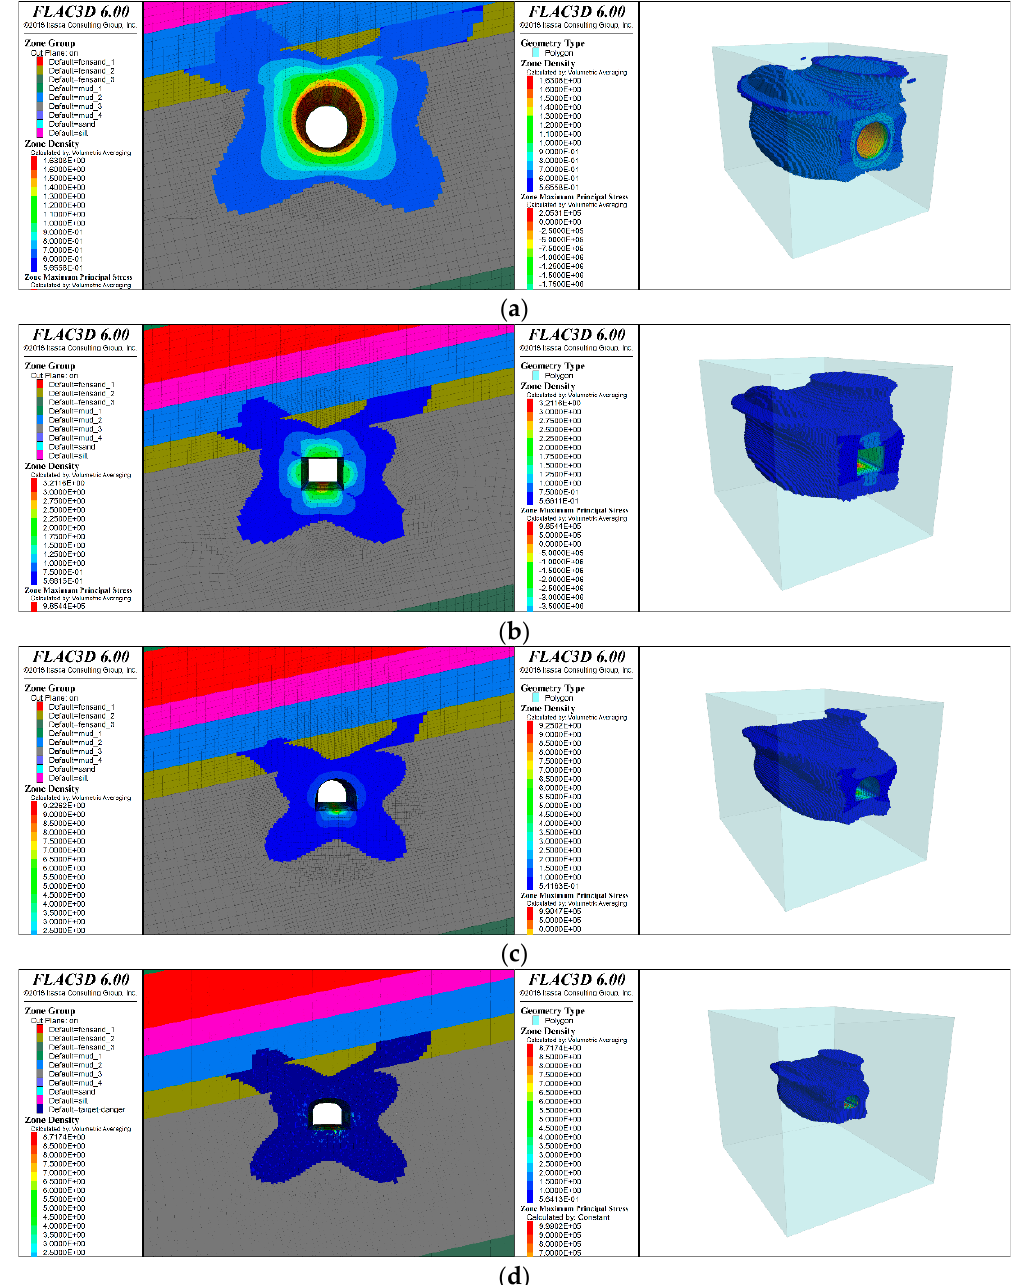
Figure 9. Influence of section shape on destructive danger area form of the rock surrounding a bottom drainage roadway. ( a ) Circular section; ( b ) Rectangular section; ( c ) Semicircular arch section; ( d ) Three-center arch section.